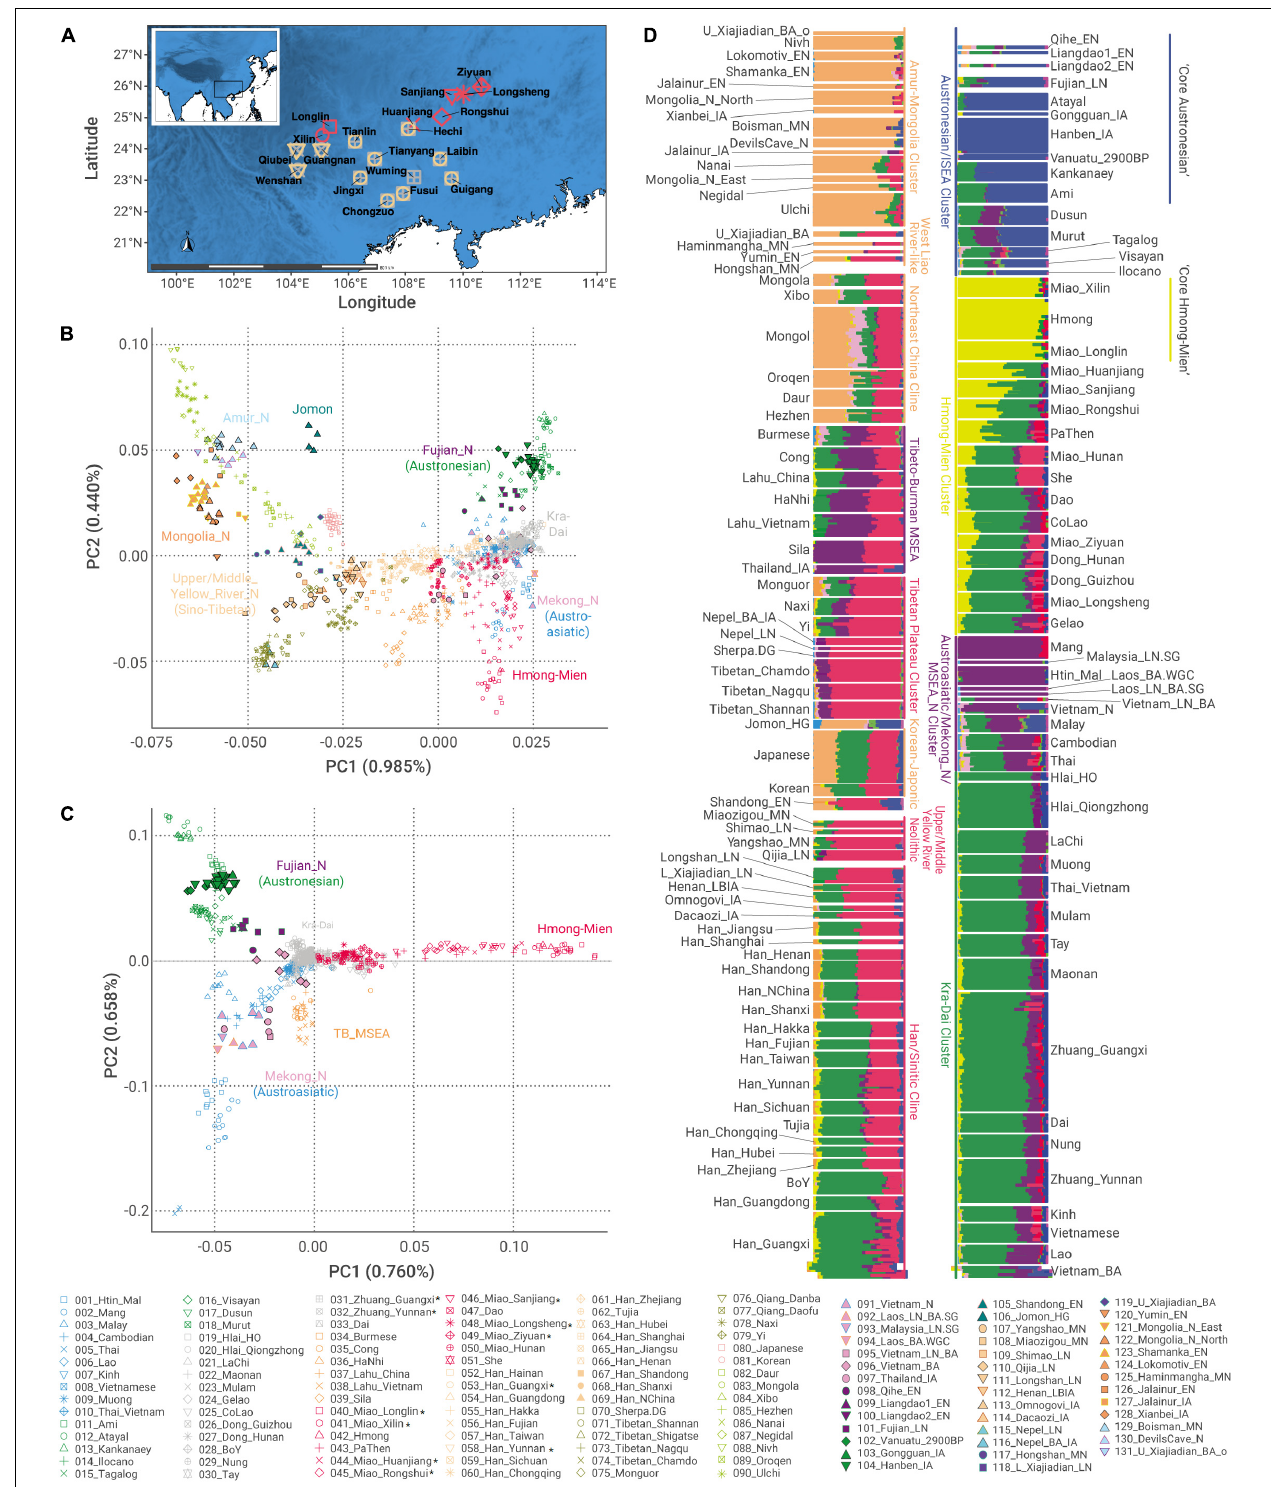
FIGURE 1 | An overview of newly reported samples and genetic structure of East Asians (A) locations of newly reported individuals in this study. (B,C) Principal component analysis for (B) all the East-Asians and (C) Southern East Asians. We projected ancient samples to principal components (PCs) constructed by modern samples. TB_MSEA, Tibeto-Burman speakers in Mainland Southeast Asia. (D) Unsupervised ADMIXTURE plot at K = 10, identifying six major ancestries in East Asia: orange, Tungusic/Northeast Asian-related; red, Sino-Tibetan-related; blue, Austronesian-related; green, Kra-Dai-related; yellow, Hmong–Mien-related; purple, Austroasiatic-related. Newly sampled populations are in asterisk (*).